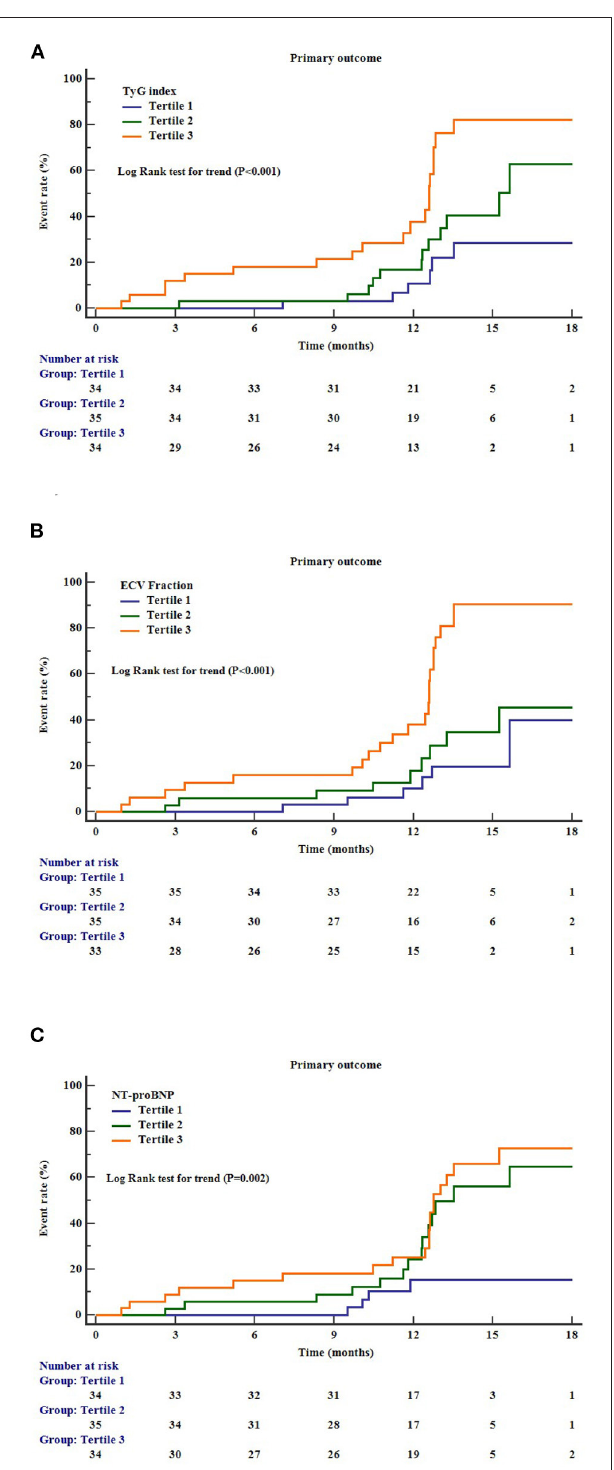
FIGURE 2 | Cumulative incidence curves for the primary outcomes according to the different markers. (A) TyG index, triglyceride–glucose index; (B) ECV, extracellular volume; (C) NT-proBNP, N-terminal pro–B-type natriuretic peptide.